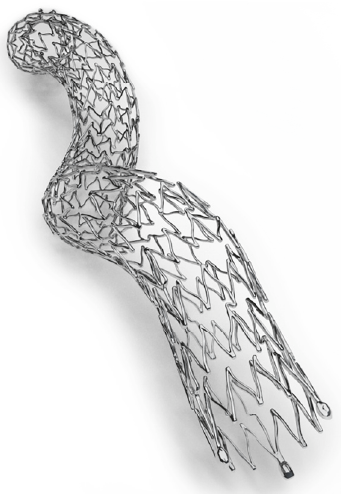
Figure 3: The BioMimics 3D stent (Veryan Medical, Horsham, United